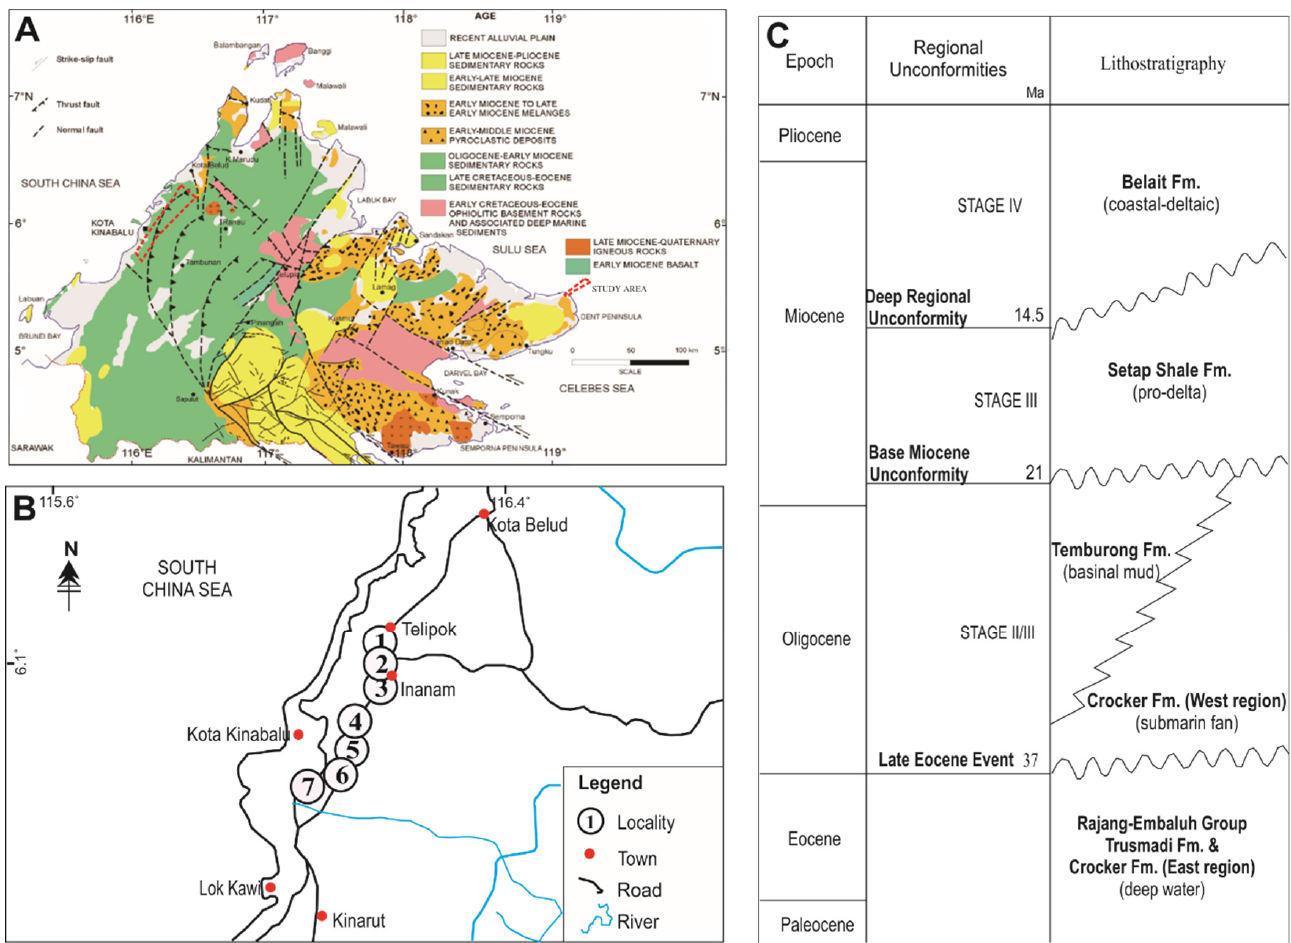
Figure 1. ( A ) Location of the study area within the geological distribution of Sabah. ( B ) Location of the outcrops, (1) Hap Seng Quarry, (2) KFC UMS, (3) Prime Kondo University, (4) Lorong Suria Inanam, (5) Kg. Divatto, (6) Taman Okk Lojungah, and (7) Pekan Kinarut. ( C ) Chronostratigraphic chart of the Sabah area.